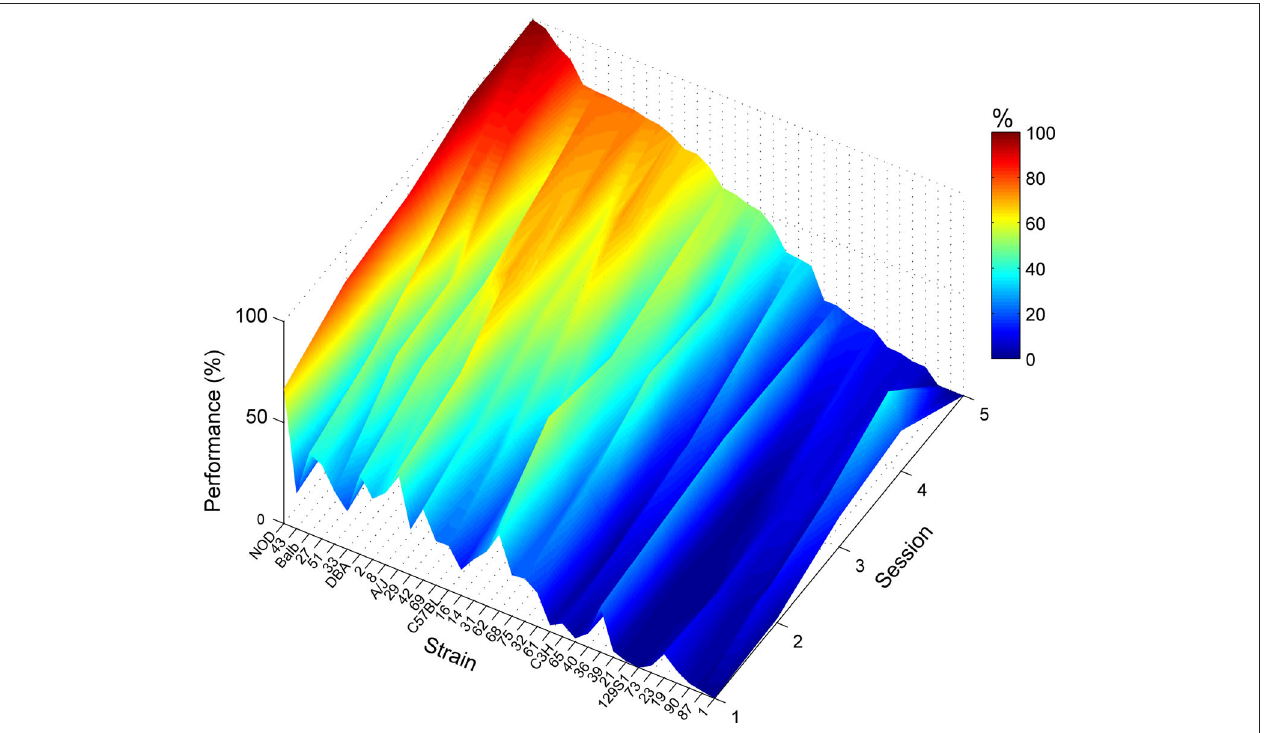
sorted based on their level of performance. A few of the mice did not complete the 5th session of training (which causes the drop in performance of lines 87 and 1), in which case we used the average of the last session of each mouse as the best available approximation for the final performance of the strain ( Figure 2C ).